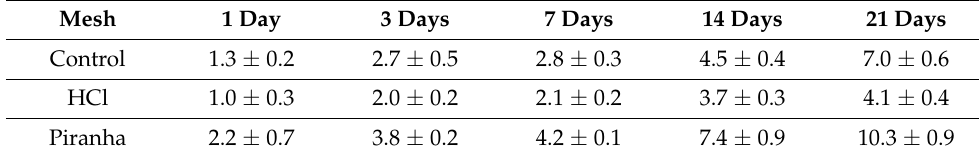
Table 5. Ti ion release (ppb) at different incubation times in Hank’s solution.